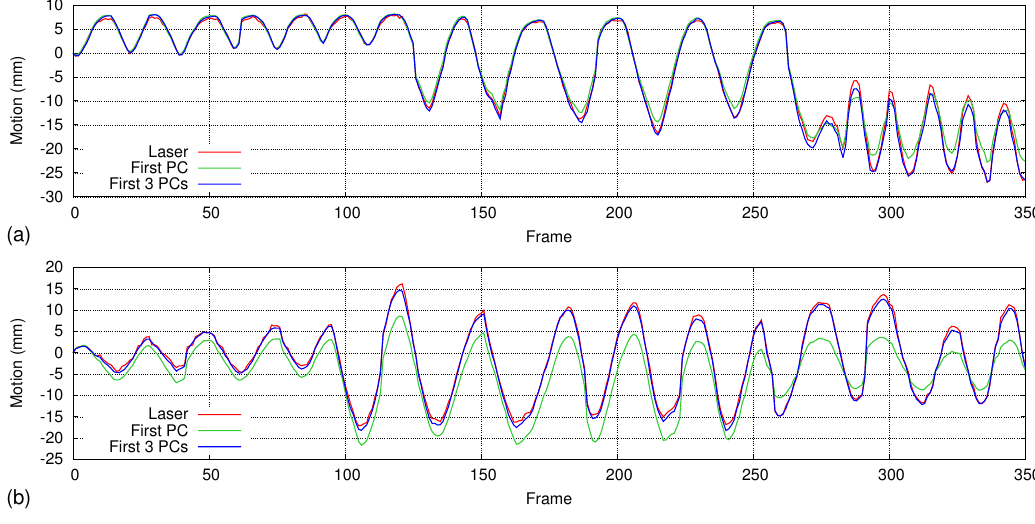
Figure 17. Motion comparison graphs generated for irregular respiratory patterns over a longer duration (350 frames). The first 100 frames are used for PCA, and the first principal component and first three principal components are used as the motion models, respectively. All frames are then used for accuracy analysis. A large difference appears between the laser scanner and PCA method when we are using only the first principal component. Higher accuracy could be achieved when we are using the first three principal components as the motion model. Graphs ( a , b ) show the motion comparison results of two different